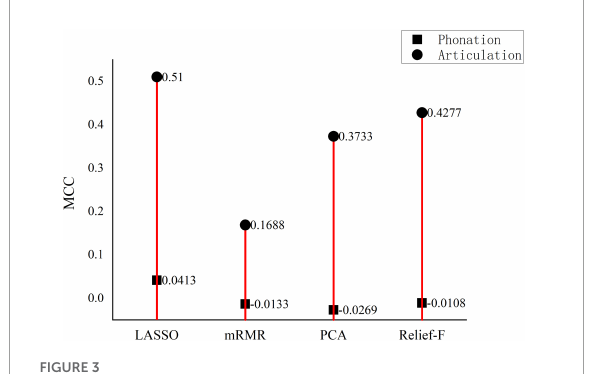
FIGURE3 Comparison of Matthews correlation coefficient values from different